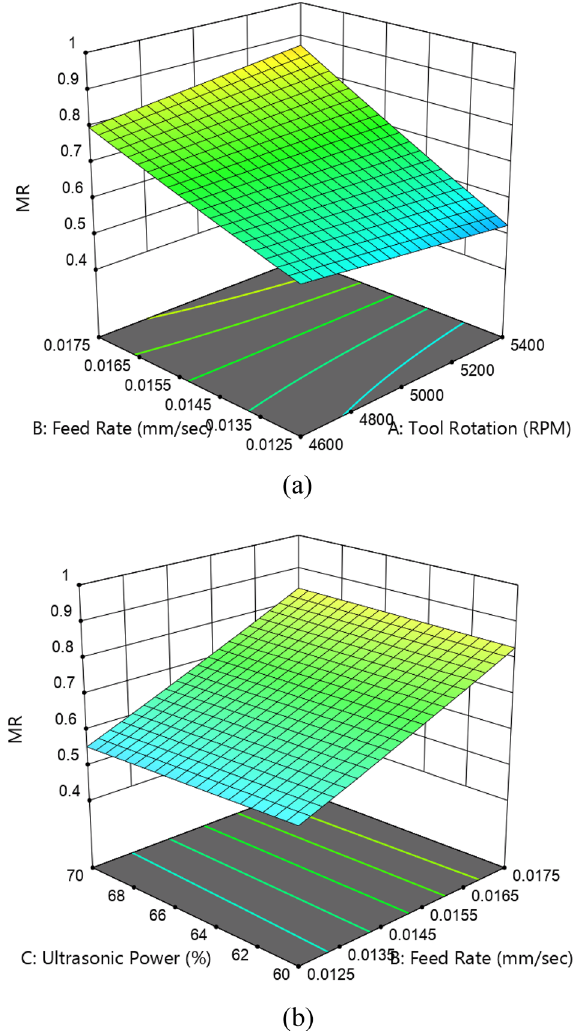
Figure 10. 3D-contour plot of interaction effect ( a ) feed rate and tool rotation ( b ) feed rate and ultrasonic power on